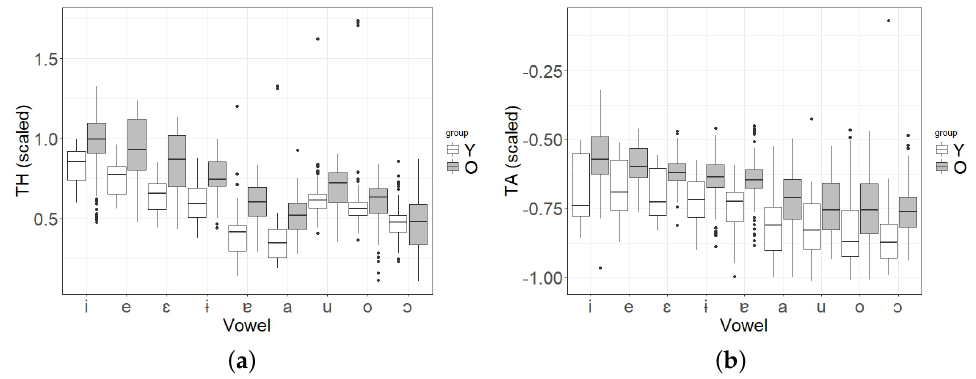
Figure A1. Boxplots of TH ( a ) and TA ( b ) scaled values by vowel and age group of all tongue contours automatically